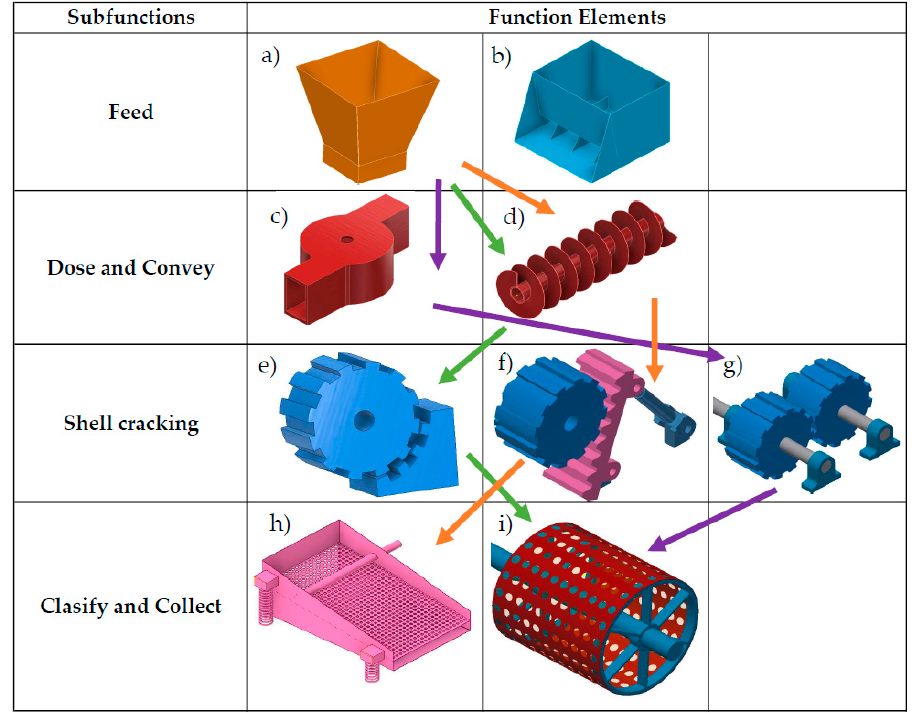
Figure 6. Morphological table with functional elements: ( a ) chute; ( b ) chute with channels; ( c ) circular dosing unit; ( d ) screw conveyor; ( e ) toothed wheel with a curved toothed wall; ( f ) toothed wheel with a tilted toothed wall; ( g ) two toothed wheels; ( h ) vibrating screen; ( i ) rotating screen.